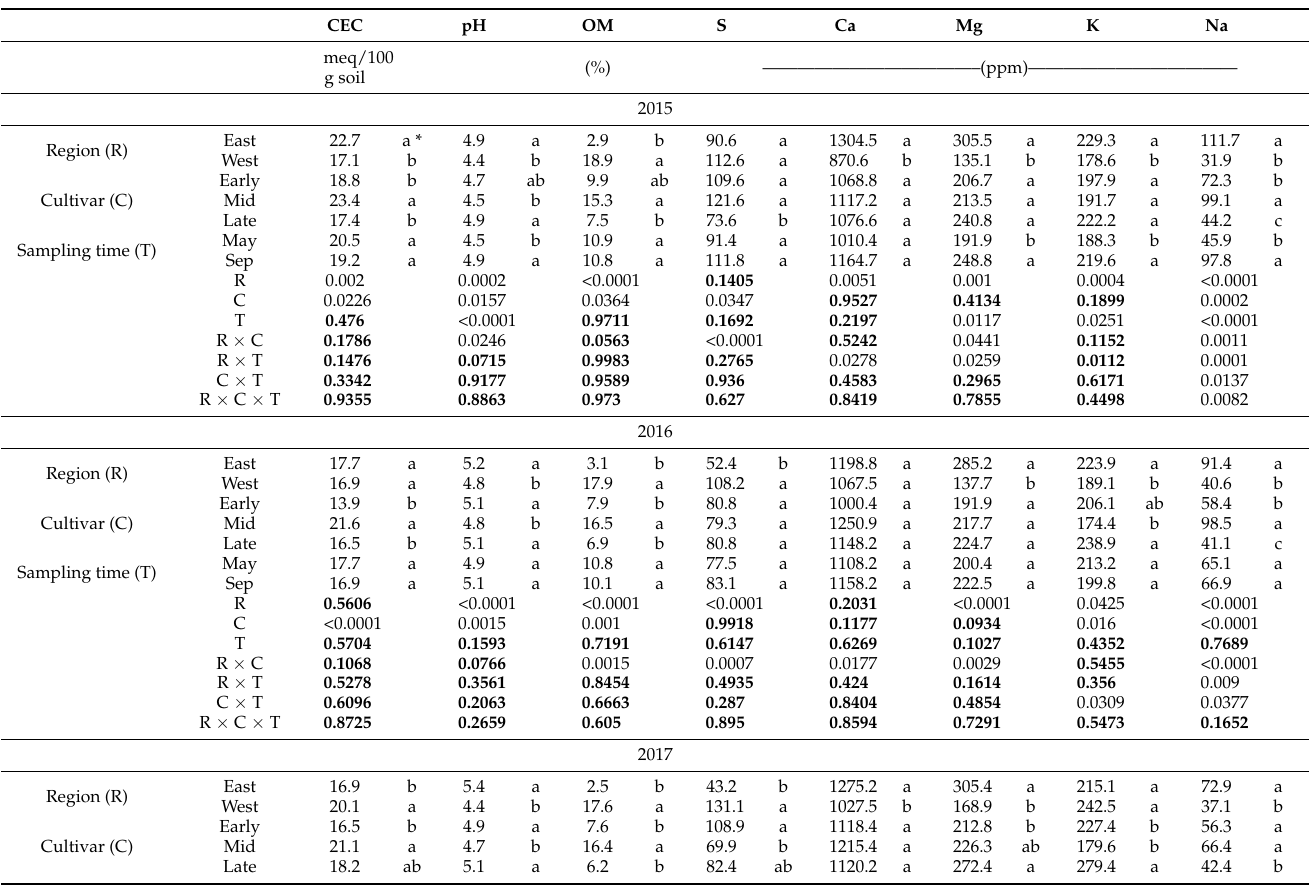
Table 2. The effect of growing region (R), cultivar (C), and day of year (DOY) on the soil nutrients in northern highbush blueberry systems in eastern and western Washington. ‘Duke’ was the early- season cultivar, ‘Draper’ the mid-season cultivar, and ‘Aurora’ and ‘Liberty’ the late-season cultivars in eastern Washington and western Washington, respectively. Non-significant effects are highlighted with bold text.